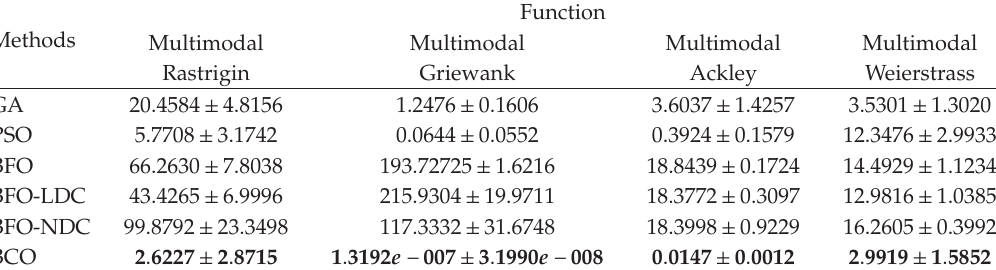
Table 3: Experimental results on benchmark functions f 5 ∼ f 8 (cid:3) 15-D (cid:4) .